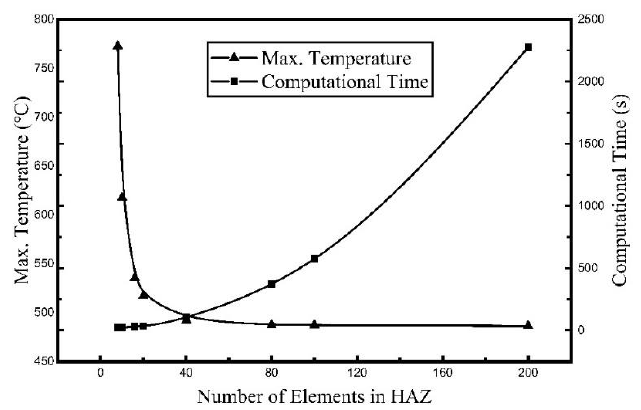
Figure 5. Relationship between maximum temperature and computational time and number of elements in the heat affected zone (HAZ).